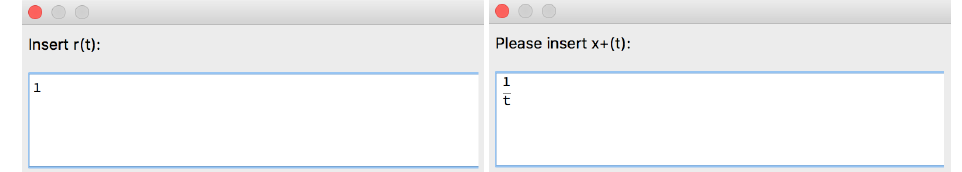
Figure 60. Part of the structure of the [SInt] 2.0 algorithm responsible for the input options. In this example, as the function x + is not validated by the algorithm (x + / ∈ R + ( T ) ), it is not possible to input any particular function y − . The output presented in Figure 61 is obtained.